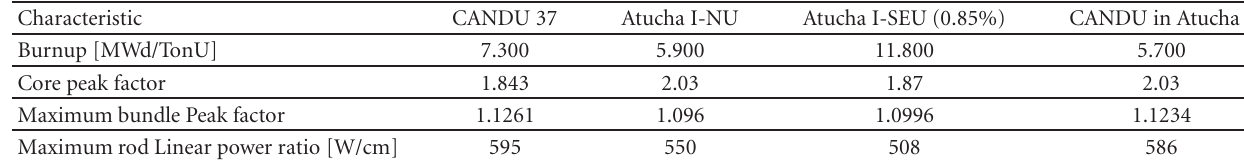
Table 5: Neutronic maximum rod power ratio and burnup for Embalse and Atucha I.